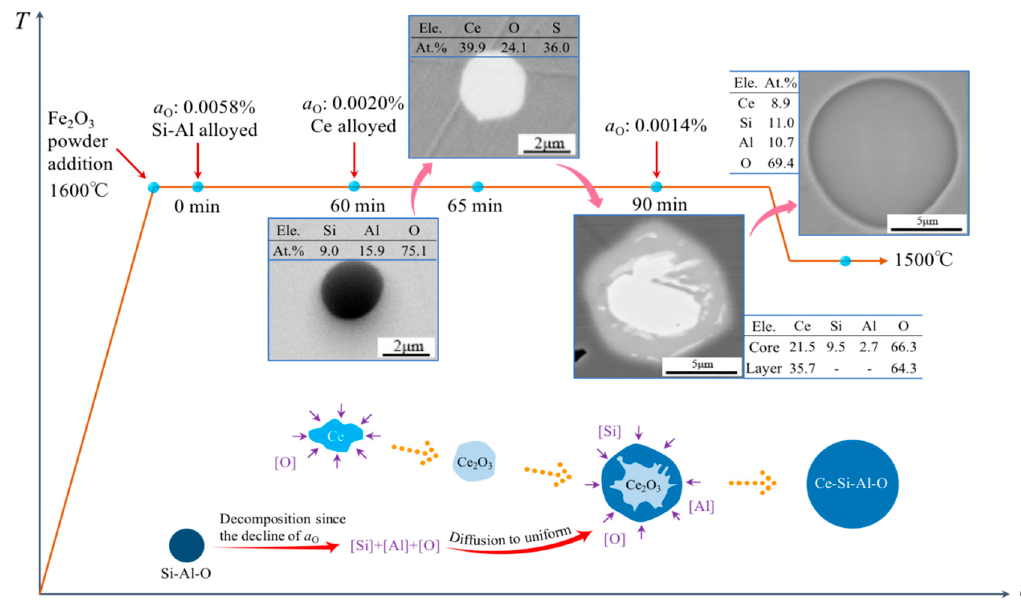
Figure 6. Inclusions evolution in 253MA steel after Al addition.